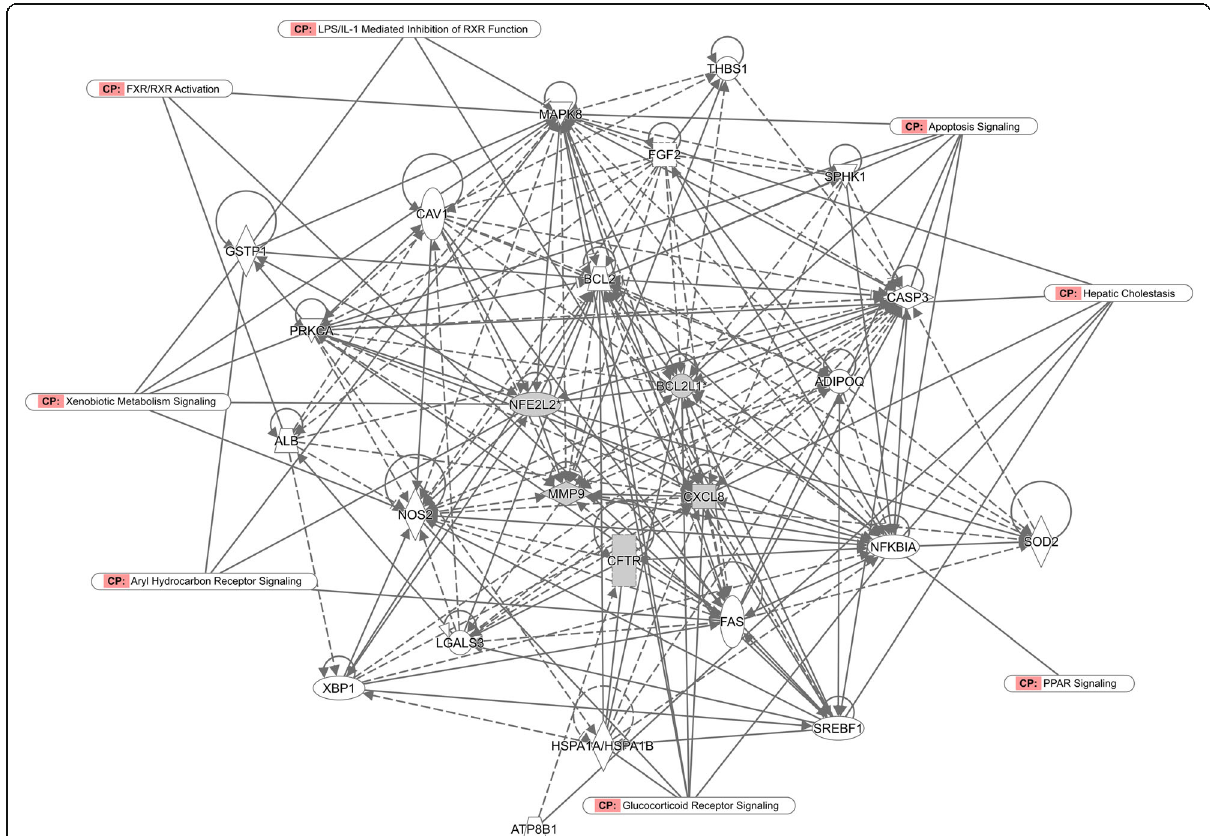
Fig. 6 The molecular network of both DILI and